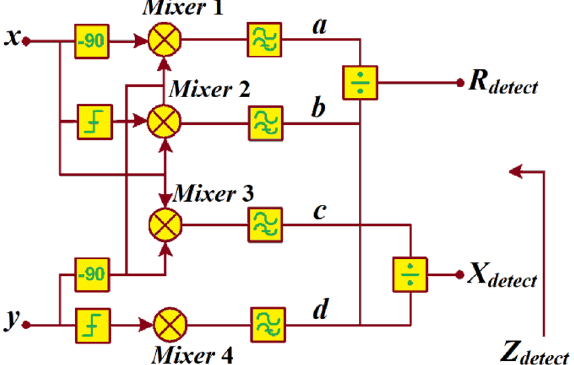
Figure 4. Quadrature detector to generate the constituent parts of the detected impedance from the